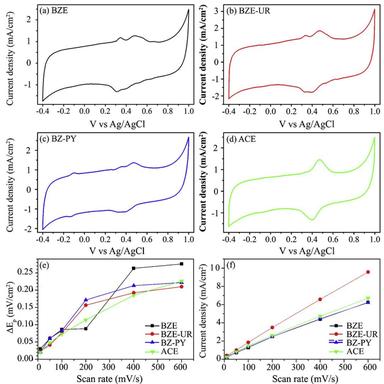
(aed) Cycle voltammetry measurement for the N-CFS (electrode) in 0.5 M H2SO4 aqueous solution with a scan rate of 100 mV/s. (e) Potential difference between anodic and cathodic peaks (DEp) and (f) anodic current density as a function of the scan rate. N-CFS, nitrogen-doped carbon fiber sponge; BZ-PY, pyridine-benzylamine; ACE, acetonitrileethanol; BZE-UR, BZE saturated with urea; BZE, benzylamine-ethanol.